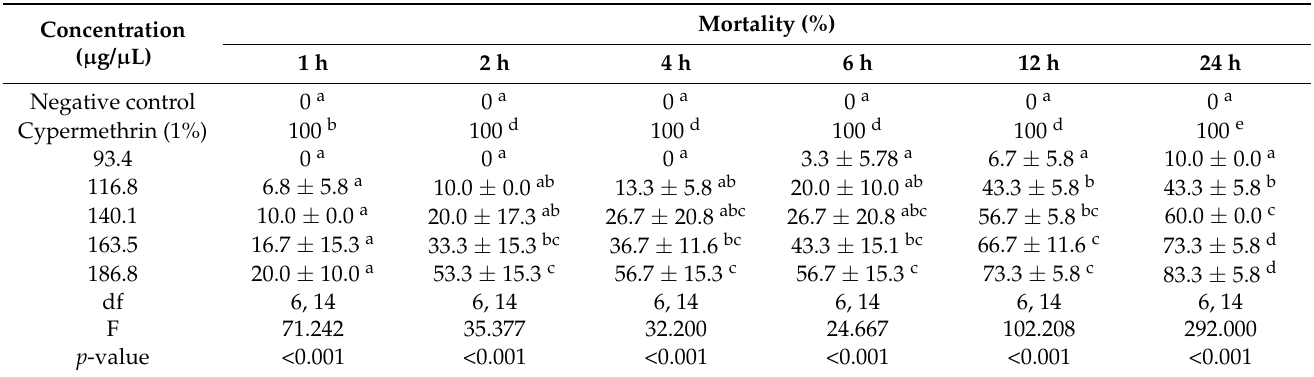
Table 2. Percent mortality (mean ± SD) of insecticidal activity of Plectranthus amboinicus essential oil against Tabanus megalops by contact toxicity test at different